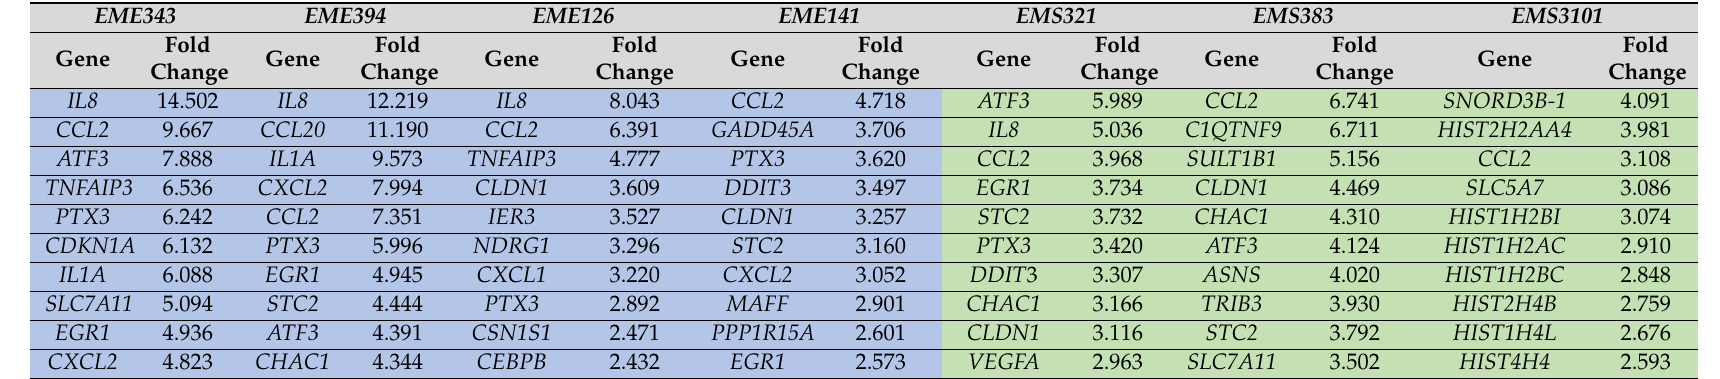
Table 1. Top 10 di ff erentially upregulated genes identified by genome-wide human expression microarrays. * Genes were considered significantly di ff erentially expressed when (a) a t-test p- value was less than 0.05 and (b) a cuto ff in transcript abundance reached at least 1.5-fold change. The 10 most upregulated genes for each strain are displayed in the